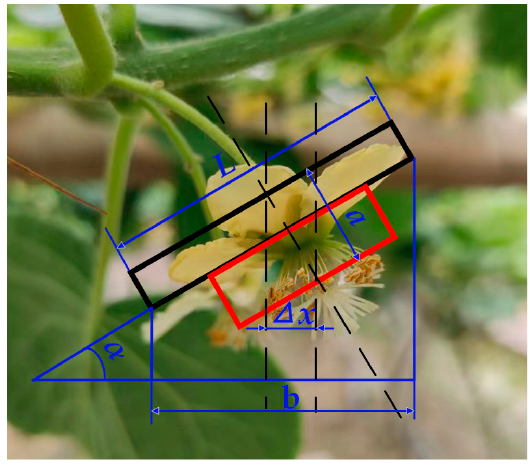
Figure 4. Flower tilt model.